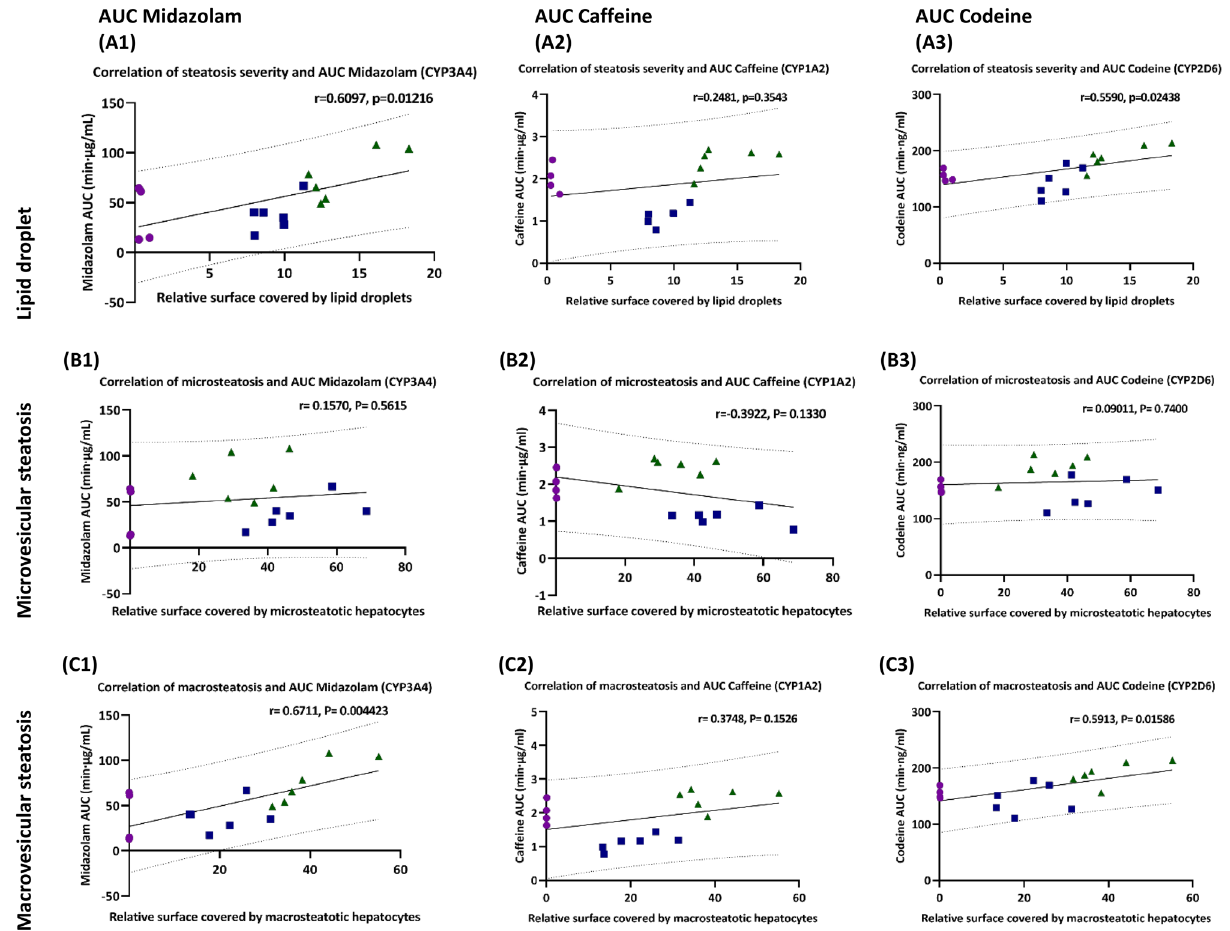
Figure 7. Correlation between steatosis severity and AUC (A-C). (Row A) Severity of steatosis as determined by lipid droplet analysis in percent of surface; (Row B) Extent of microvesicular steatosis, in percent of surface; (Row C) Extent of macrovesicular steatosis, expressed in percent. (Column 1) Correlation of steatosis type and severity with AUC of Midazolam; (Column 2) Correlation of steatosis type and severity with AUC of caffeine; (Column 3) Correlation of steatosis type and severity with AUC of codeine. Control as magenta circles, two weeks HF-diet as blue squares, four weeks HF-diet as green